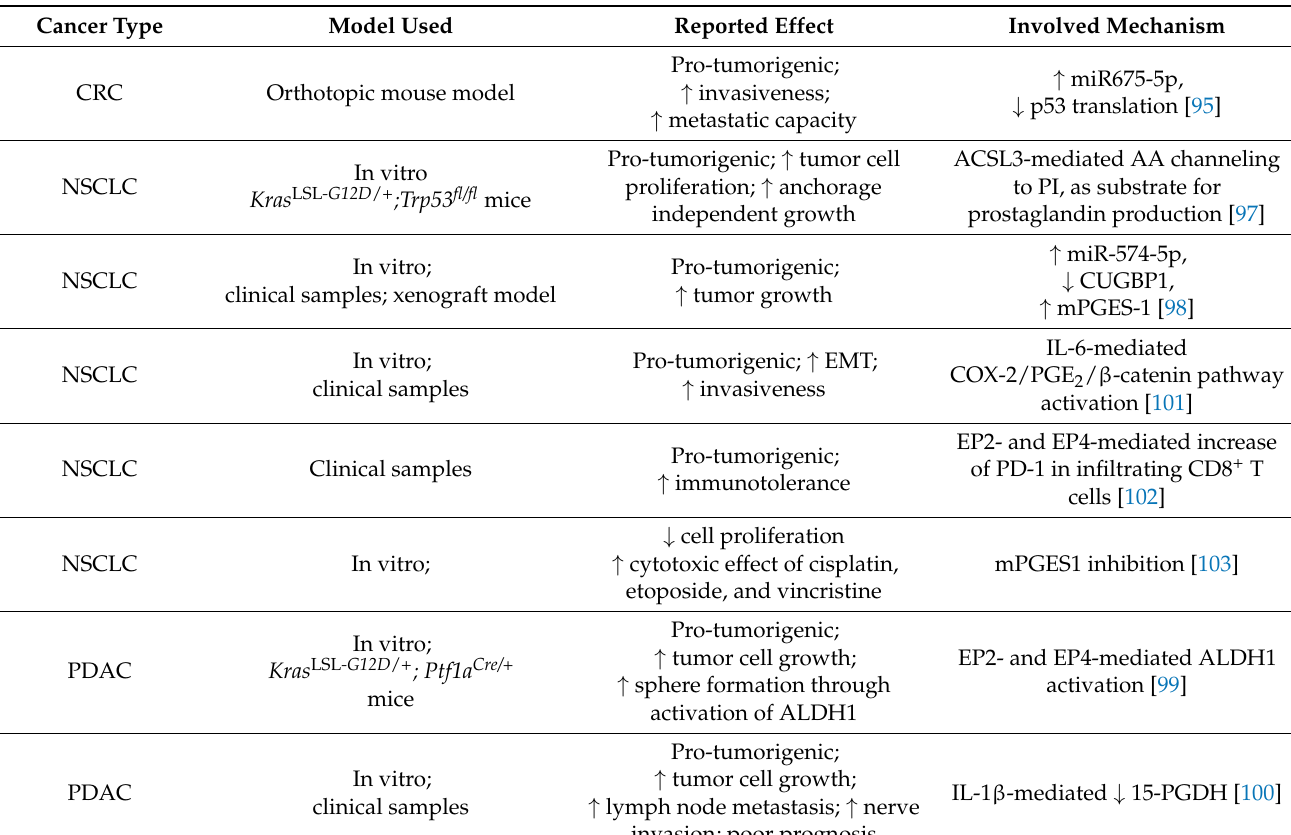
Table 1. Effect of prostaglandins in different cancer types and the implicated driving